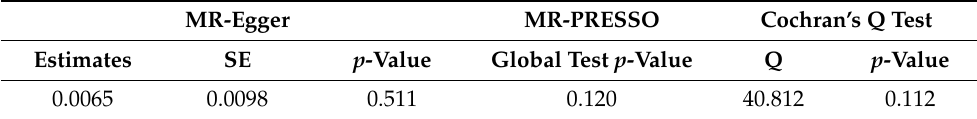
Table 4. Sensitivity analyses of the causal effect of metformin treatment on RA. MR-Egger MR-PRESSO Cochran’s Q Test Estimates SE p -Value Global Test p -Value Q p -Value 0.0065 0.0098 0.511 0.120